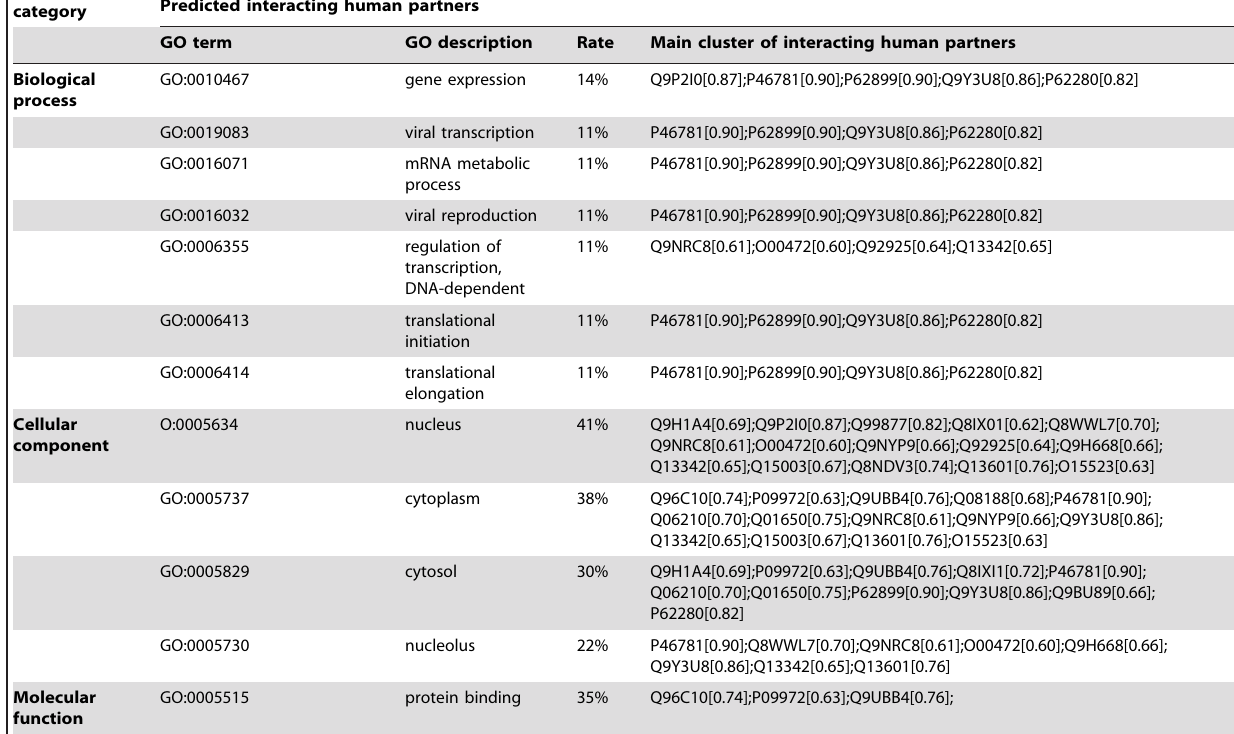
Table 5. Predicted interactions between Rev and human